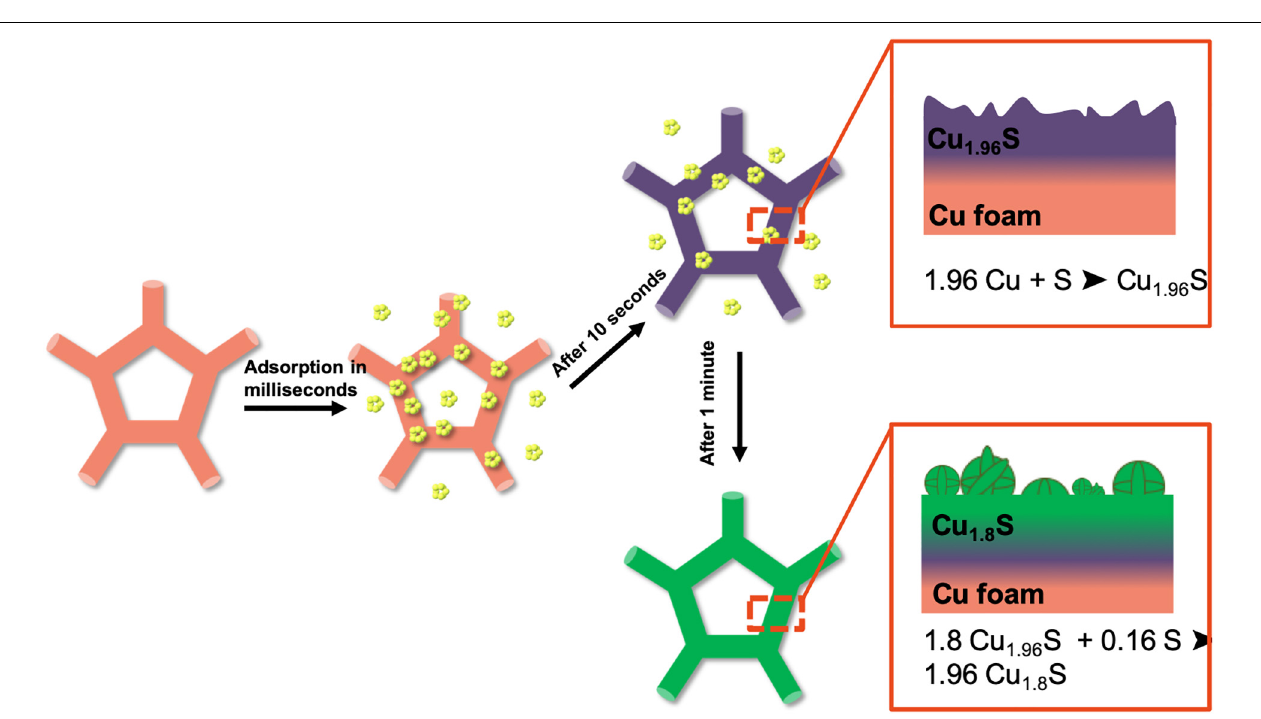
allowed the rapid diffusion of Cu ions out of the crystal, thereby increasing the surface oxidation which possibly accelerated the djurleite formation (Green et al.,